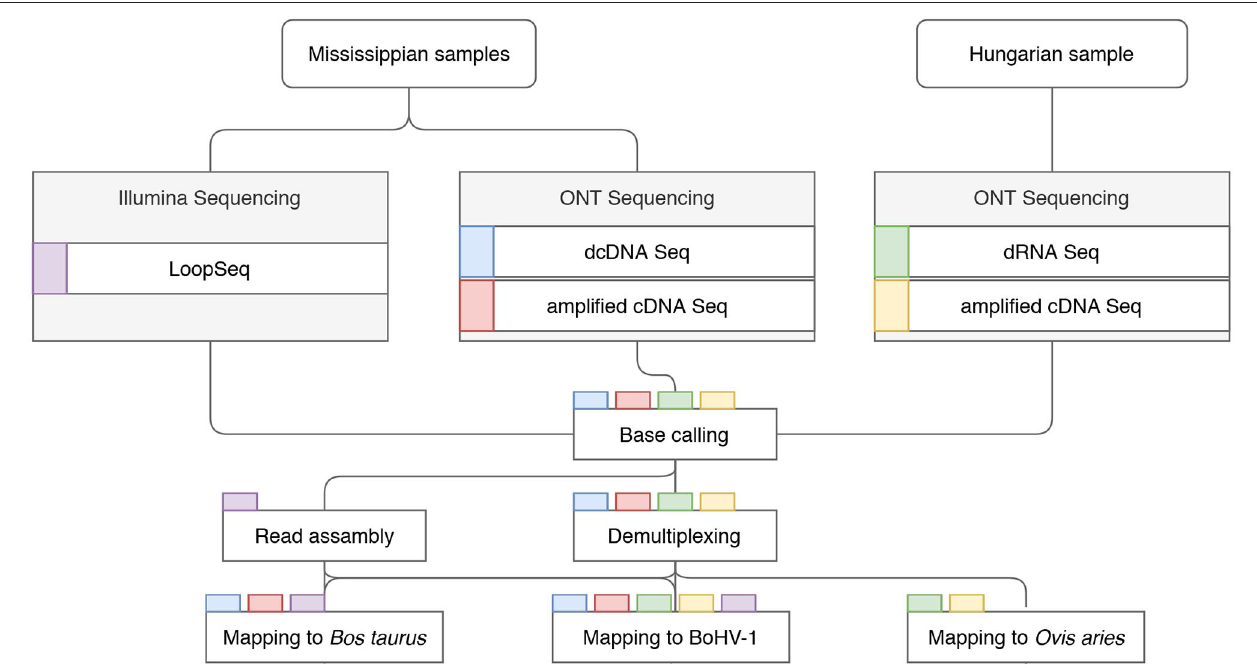
FIGURE 1 | Detailed workflow of the project. Data flow chart shows the overview of the study design. Colored rectangles represent the sequencing libraries. Steps of data analysis are shown in rectangles, with the libraries undergoing the given step indicated by the tab color.